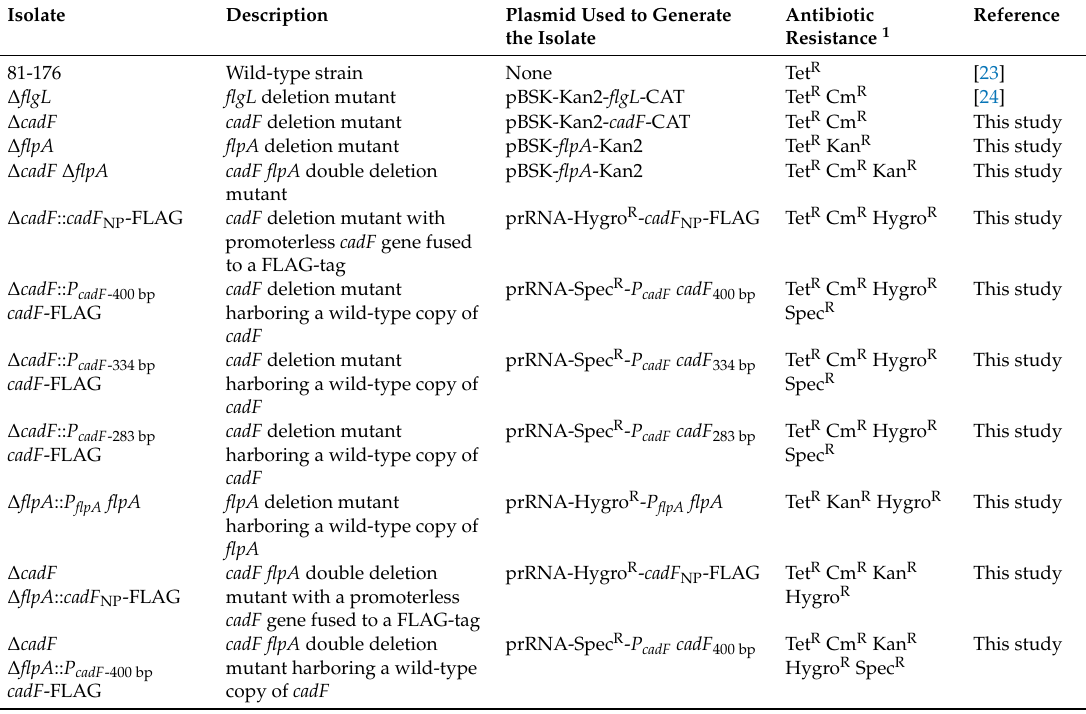
Table 1. C. jejuni isolates used in this